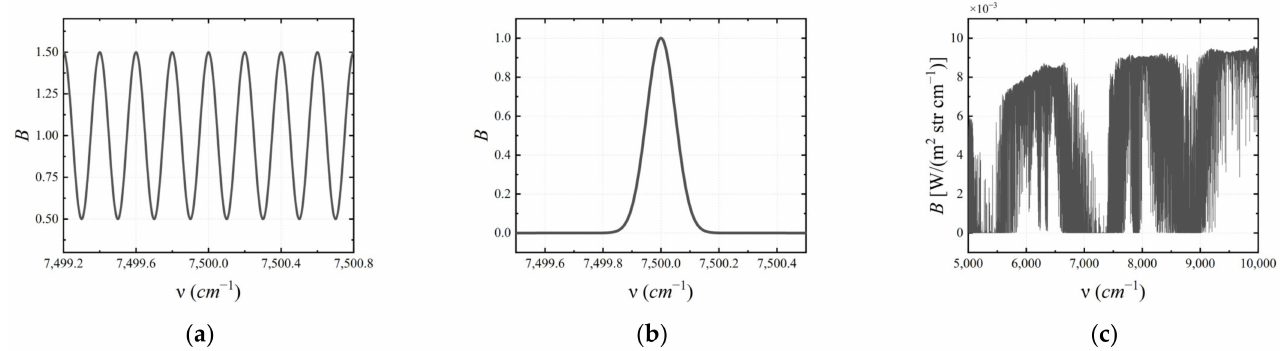
Figure 6. Input spectrum: ( a ) cosine function; ( b ) Gaussian function; and ( c ) spectral data.